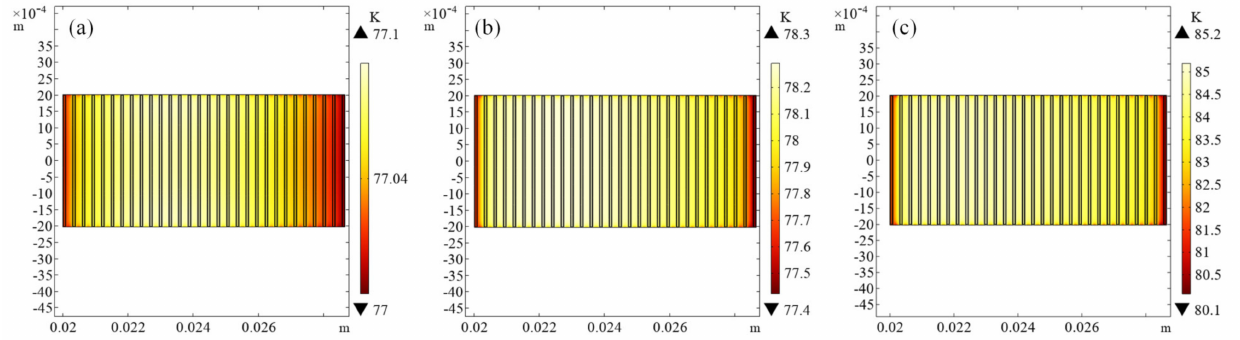
Figure 8. Temperature distributions in the REBCO coil when t = 0.3 s (( a ) I p / I c0 = 0.4, ( b ) I p / I c0 = 0.6, ( c ) I p / I c0 =